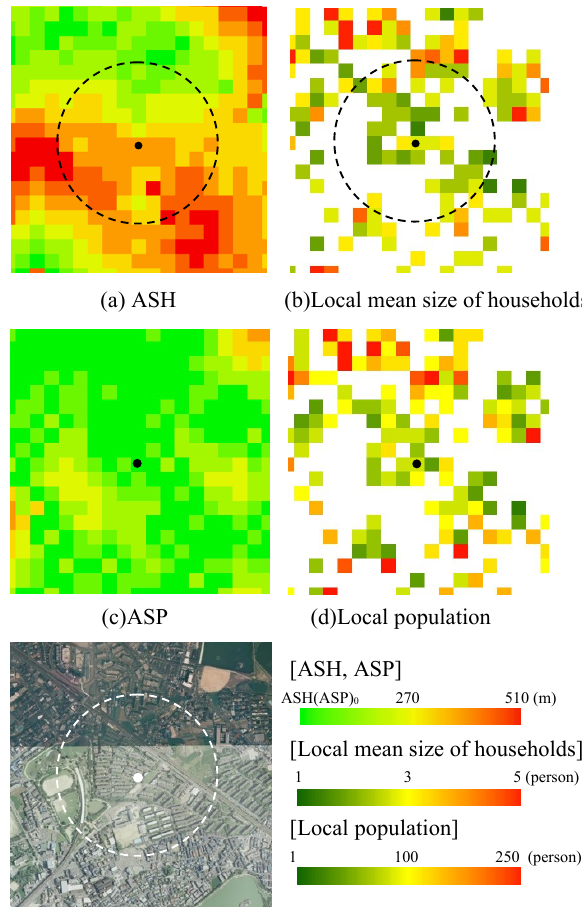
Figure 8 . Comparison between ASH, ASP and an aerial photograph in the site A of Figure 7. Dotted lines show the circles with radius ASH (= 390 m) which is indicated with colour of centre pixels in ASH images. The circle of ASP does not appear (ASP 0